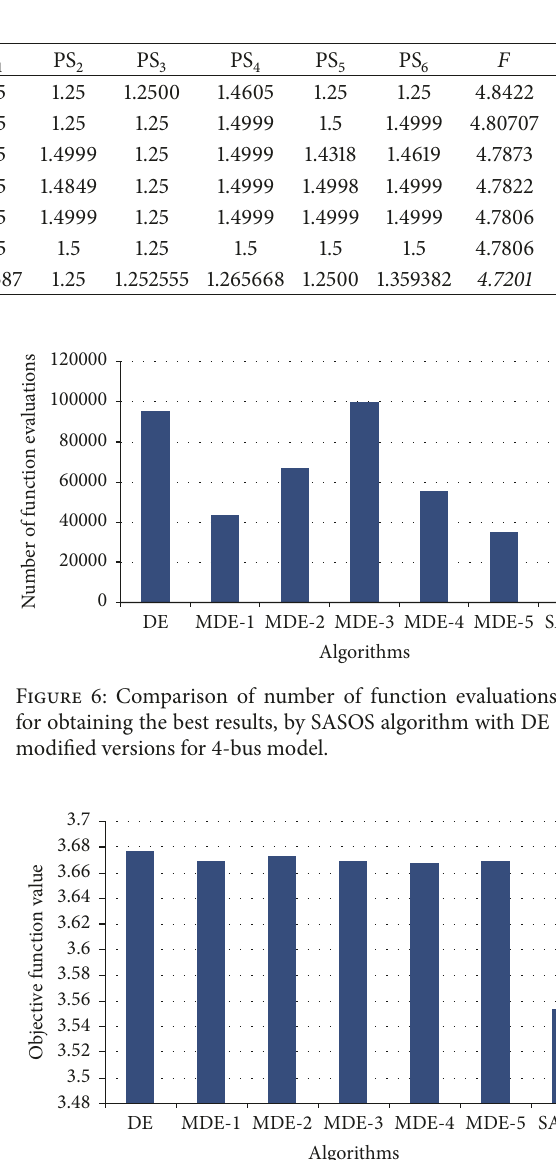
Figure 5: Comparison of best objective values obtained by SASOS algorithm with DE and its modified versions for 3-bus model.